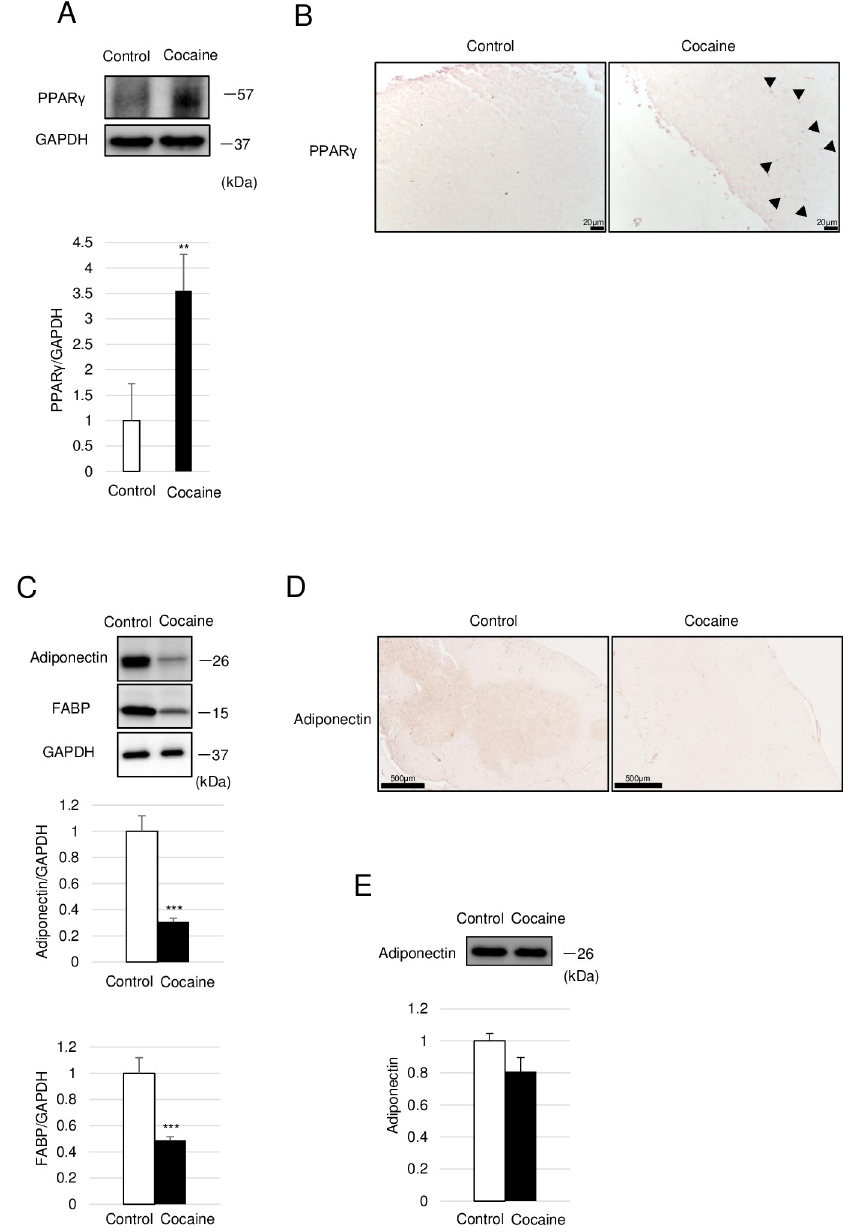
Fig 5. Increased levels of PPAR γ and decreased levels of adiponectin in thymus from rats administered cocaine for 7 days. Rats were treated with or without cocaine (20 mg/kg/day, 7 days). (A) Immunoblot analysis of PPAR γ in the thymus. GAPDH levels served as an internal control. (B) Immunohistochemical analysis of PPAR γ in the thymus. Arrowheads indicate nuclear localization of PPAR γ . (C) Immunoblot analysis of adiponectin and FABP4 in the thymus. (D) Immunohistochemical analysis of adiponectin in the thymus. (E) Immunoblot analysis of adiponectin in the serum. GAPDH levels served as an internal control. Graphs show mean and S.E. �� P < 0. 01, ��� P < 0.001 versus